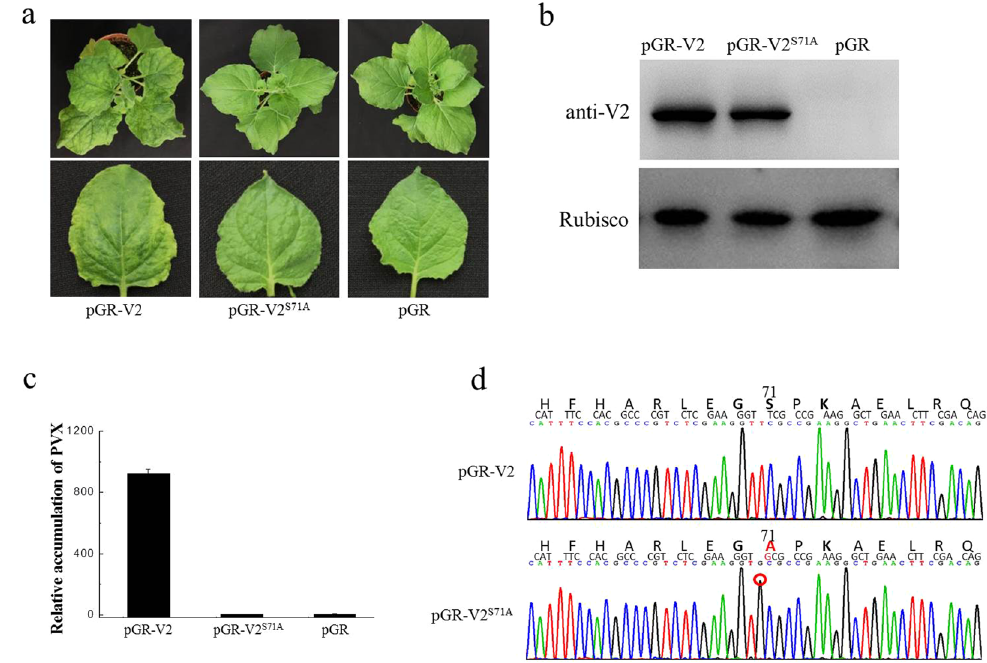
Figure 5. Symptoms exhibited by N. benthamiana plants infected with PVX expressing V2 and V2 S71A . ( a ) The symptoms of N. benthamiana plants at 16 dpi. ( b ) Western blot analyses of V2 and V2 S71A expression with pGR- V2, pGR-V2 S71A and pGR. ( c ) The virus accumulation in plants infiltrated with pGR-V2, pGR-V2 S71A and pGR.